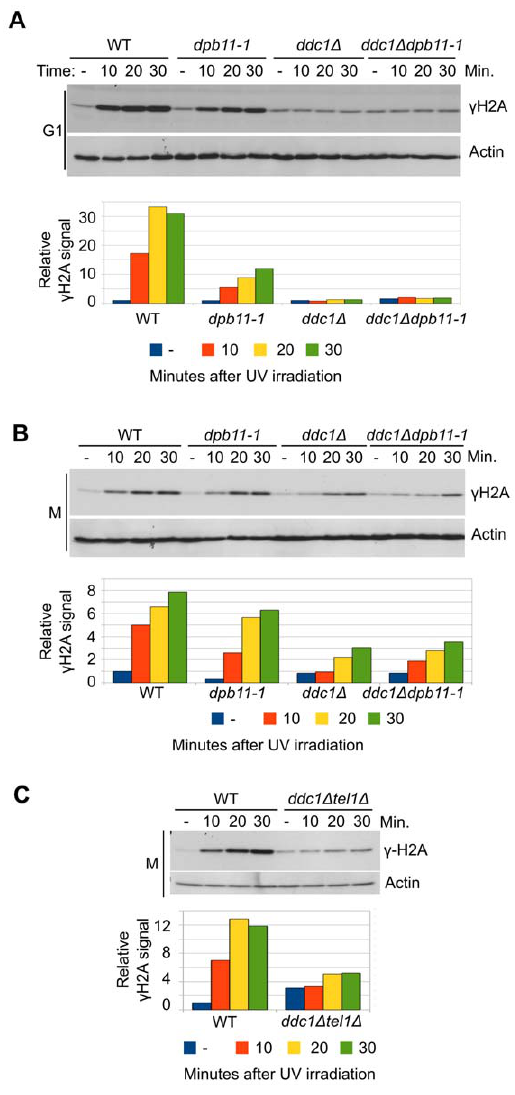
Figure 1. UV-induced Mec1 activation requires the 9-1-1 complex and the Dpb11 C-terminus. (A) K699 (WT), YFP20 ( dpb11-1 ), YAN21/8d ( ddc1 D ), YFP62/1d ( ddc1 D dpb11-1 ) and YMIC5A3 ( mec1-1 ) strains were grown to mid-log phase, arrested in G1 with a - factor and subjected to UV irradiation. At the indicated time-points, protein extracts were prepared and separated by SDS-PAGE. Mec1 activation was assayed by western blotting monitoring c H2A and a - actin was used as loading control. A quantification of H2A phosphor- ylation is shown in the lower panel. The values indicate the fold increase respect to the WT untreated sample. The mec1-1 mutation is functionally equivalent to a null mutation (B) The strains in panel A were arrested in M phase with nocodazole and subjected to the same treatment. Analysis and quantification of H2A phosphorylation was carried out as described above. (C) Strains K699 (WT) and YFP223 ( ddc1 D tel1 D ) were arrested in M phase with nocodazole and UV irradiated. At the indicated time-points Mec1 activation was assayed by western blotting monitoring c H2A. A quantification of the signal corresponding to H2A-S129 is shown in the lower panel. The values indicate the fold increase respect to the WT untreated samples. experimental conditions, ddc1 D dpb11-1 double mutant cells showed a very severe defect in Rad53 phosphorylation, similar to that found in a Mec1-defective strain. These results suggest that a dpb11-1 ddc1 D double mutation virtually abolishes UV-induced